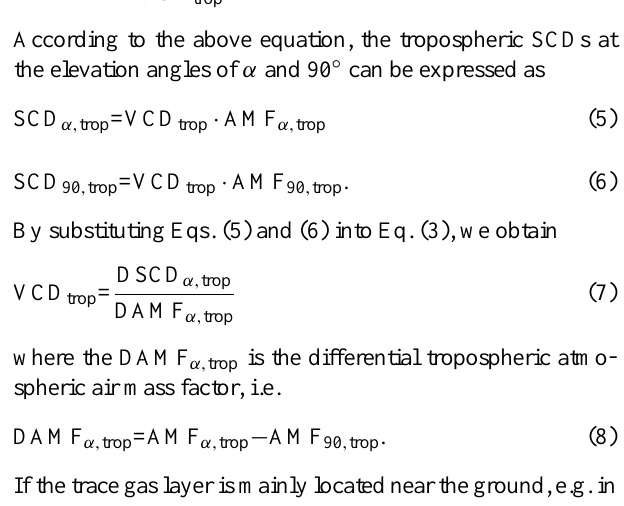
Fig. 3. Diurnal variations of the NO 2 tropospheric differential slant column density (DSCD trop ) , measured from the MAX-DOAS, and the cloud fraction (CF) observed from the satellite FY-2D. The dif- ferent sub-plots show examples for heavily polluted ( a and c ) and relatively clean ( b and d ) cases in Beijing during summer ( a and b ) and winter ( c and d ) periods, respectively. (Please note the different